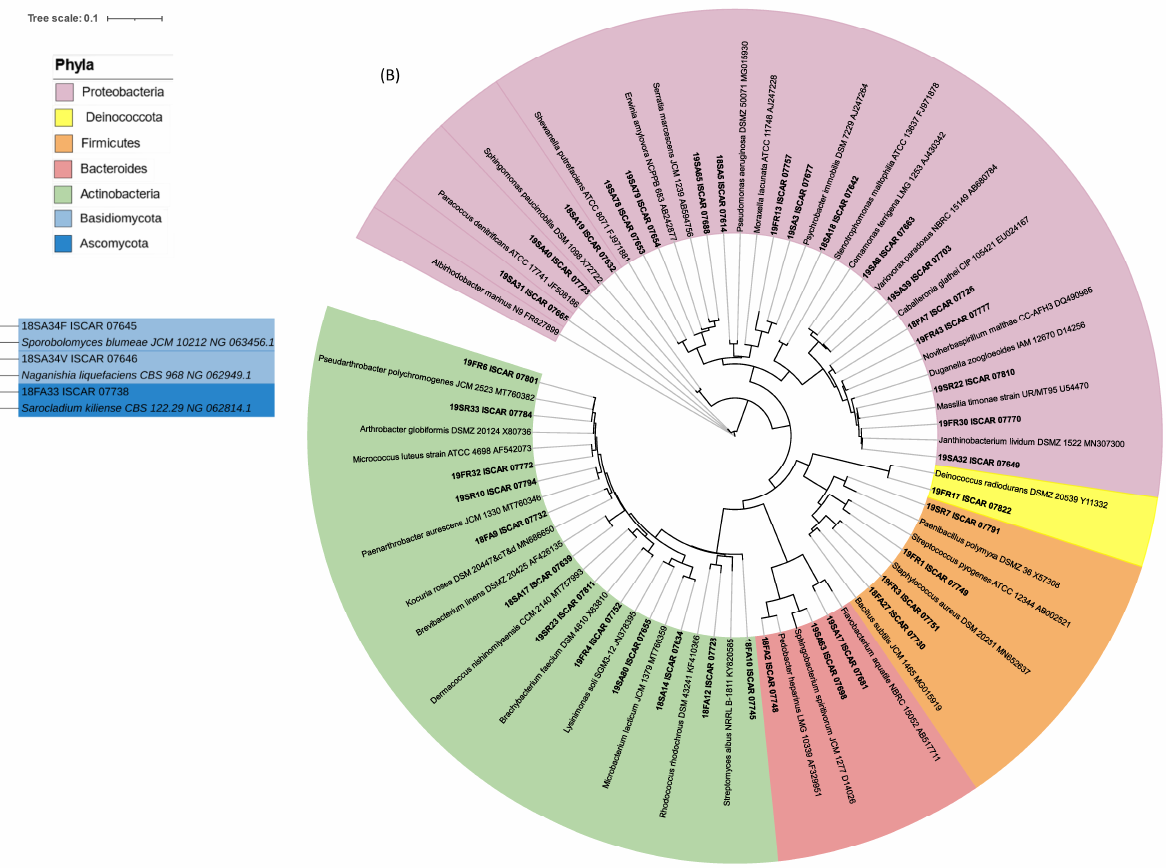
Figure 2. Phylogenetic tree of the partial 16S rRNA gene sequences of 40 strains cultivated in this study and type species of 40 different genera. ( A ) Eukaryotic strains. ( B ) Prokaryotic strains. One representative 16S rRNA gene sequence of each taxonomic group was selected to build a phylogenetic tree. Sequences were classified and aligned using the online portal of the SILVA Incremental Aligner (SINA 1. 2. 11) tool of the ARB-Silva database (http://www.arb-silva.de/aligner/, accessed on 20 August 2022). The tree computed with RAxML was imported in Interactive Tree of Life (iTOL)